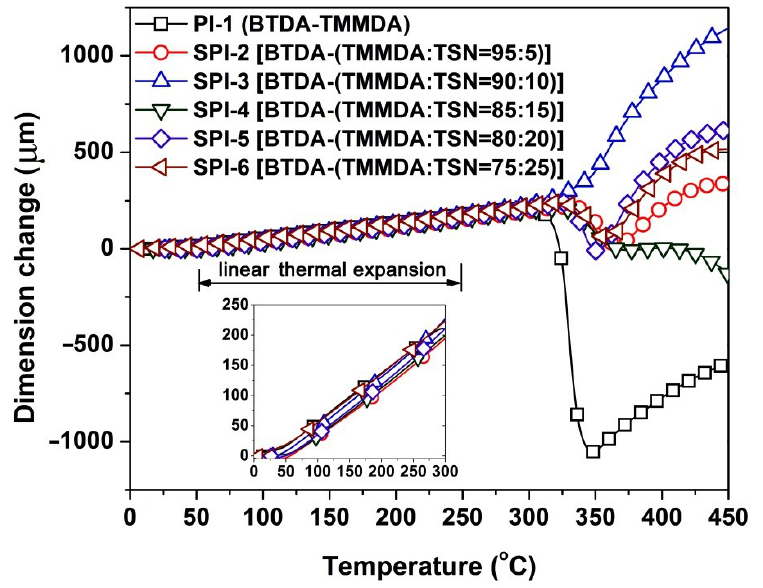
Figure 9. TMA curves of PI and SPI films. (Insert: locally enlarged TMA curves for clear demon- stration with the same X- and Y-axis